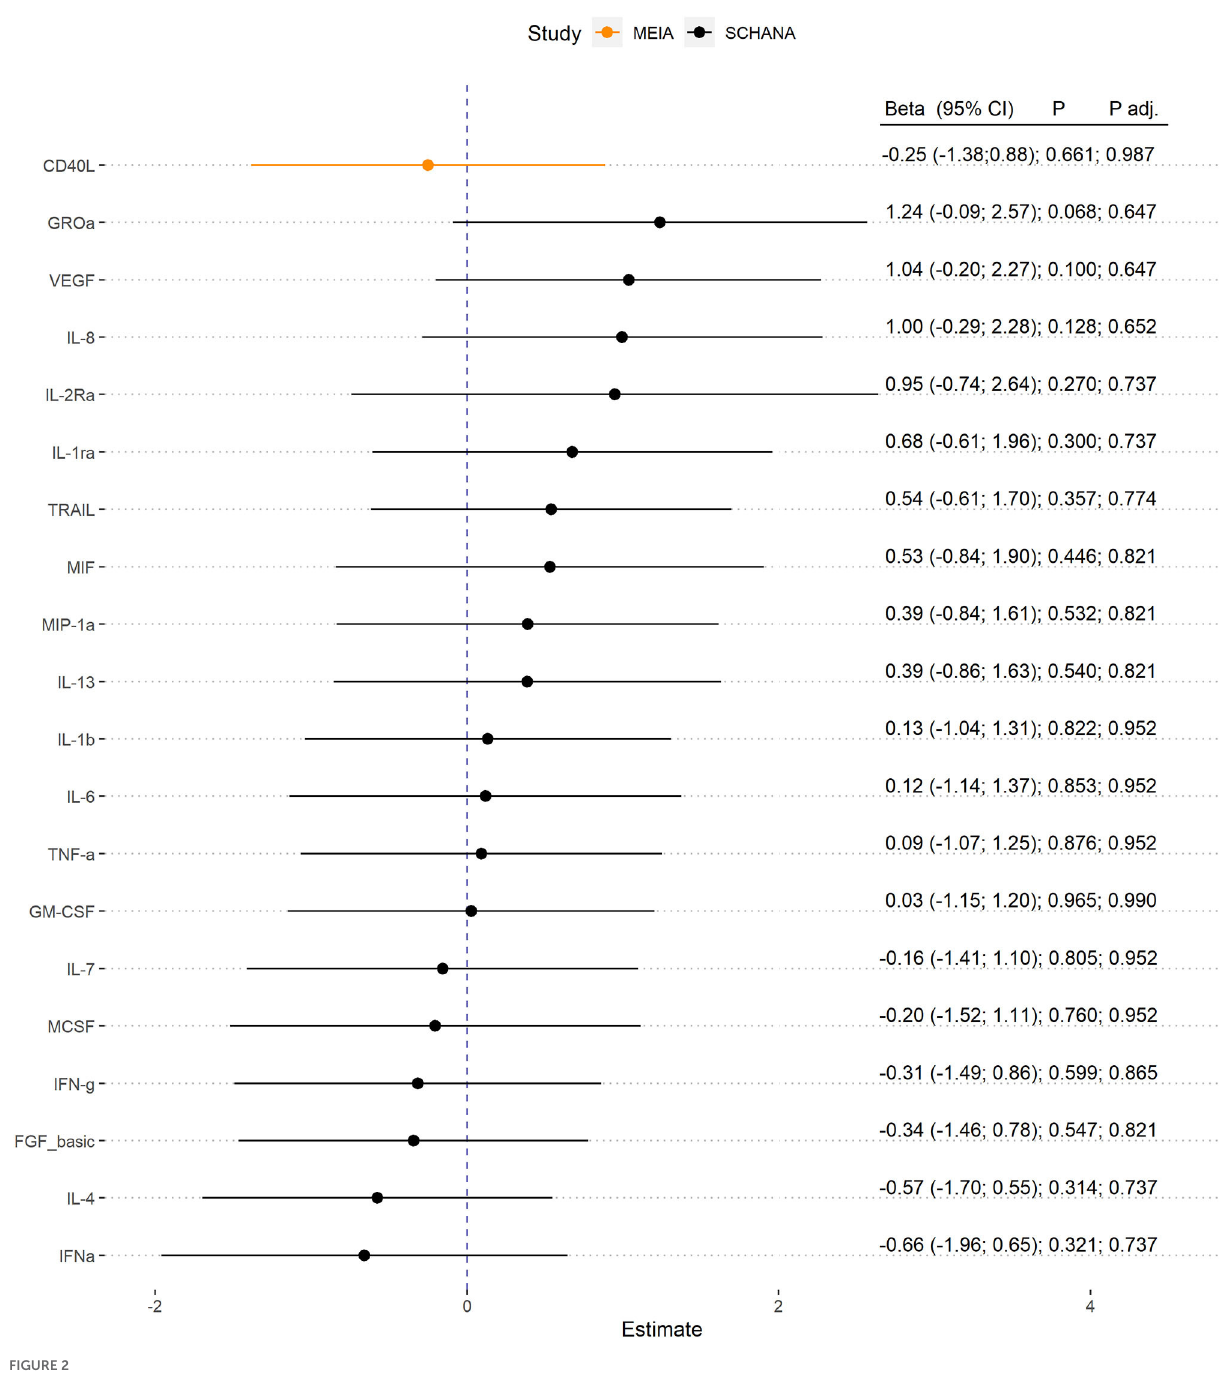
finding is in contrast to a recent study which found no differences regarding IP-10 levels when comparing patients with fatigue